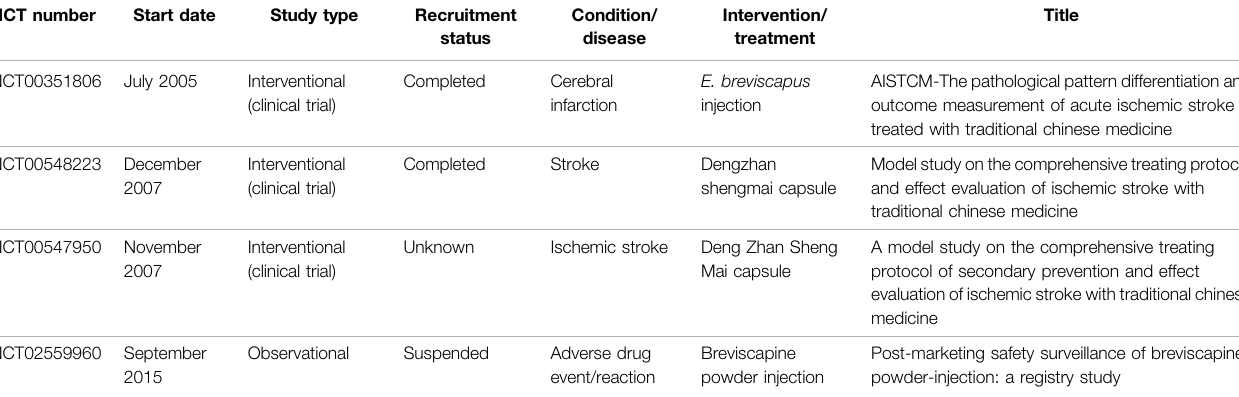
TABLE 1 | Details of our search on the clinical trial website (http://clinicaltrial.gov/) with keywords “ Erigeron breviscapus ” and “ Dengzhan ”